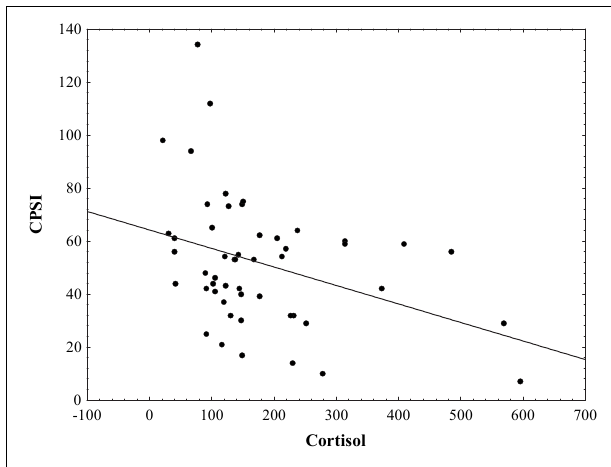
FIGURE 2 | Relationship between hair cortisol levels (pg/mg) and epileptic-like symptoms measured by CPSI.